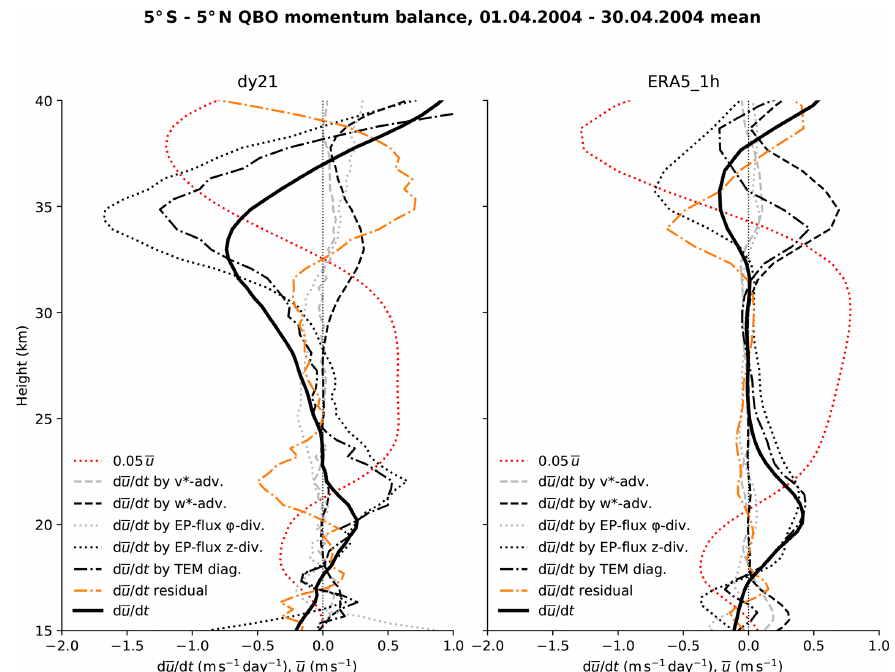
Figure 10. Zonal mean zonal wind (dotted red line) and its tendencies averaged between 5 ◦ S and 5 ◦ N and between 1 and 30 April 2004 from 15 to 40km height in the simulation dy21 and in ERA5, with the total tendency (bold line) and contributions diagnosed in the transformed Eulerian mean framework for advection by the residual meridional v ∗ and vertical wind w ∗ (dashed lines), the meridional and vertical divergence of the Eliassen–Palm flux (dotted lines), the sum of these four terms (dotted–dashed line), and the residual (dotted–dashed orange